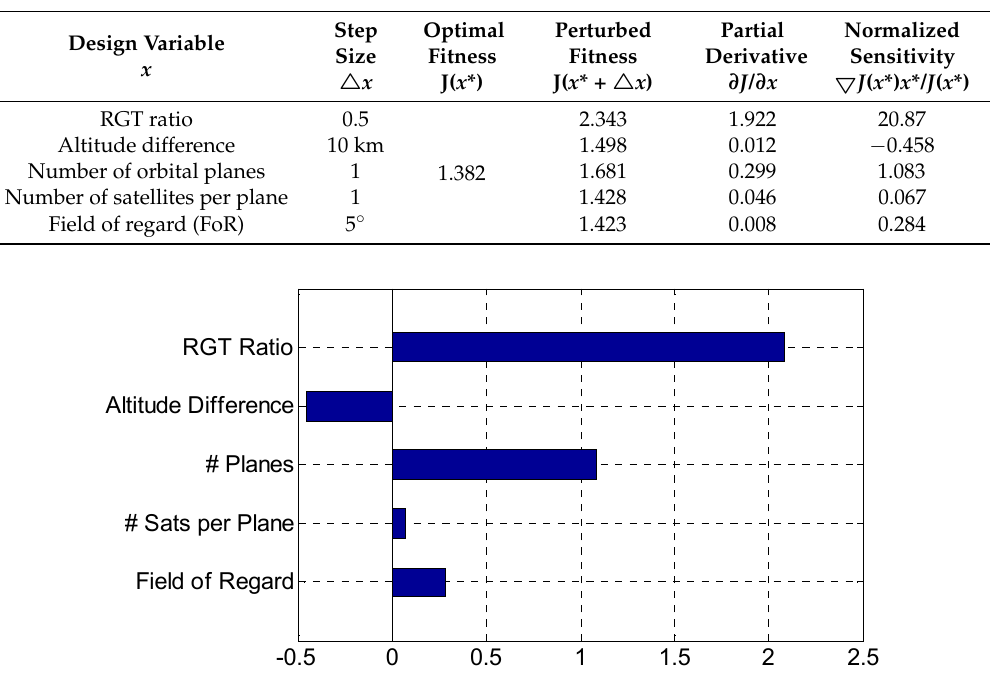
Table 20. Sensitivity at the optimal design point.